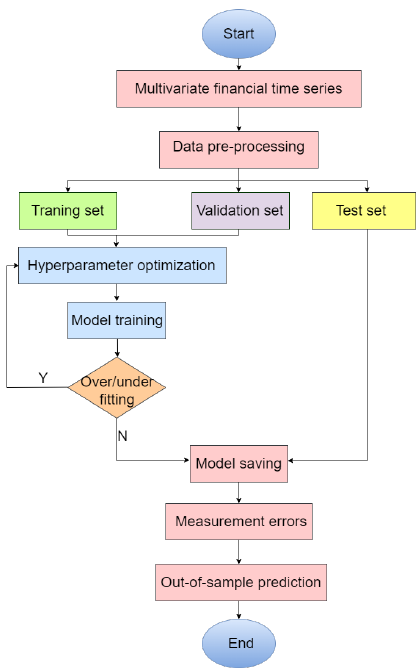
Figure 5. The single deep learning flowchart. The structure of the linear hybrid forecast is displayed in Figure